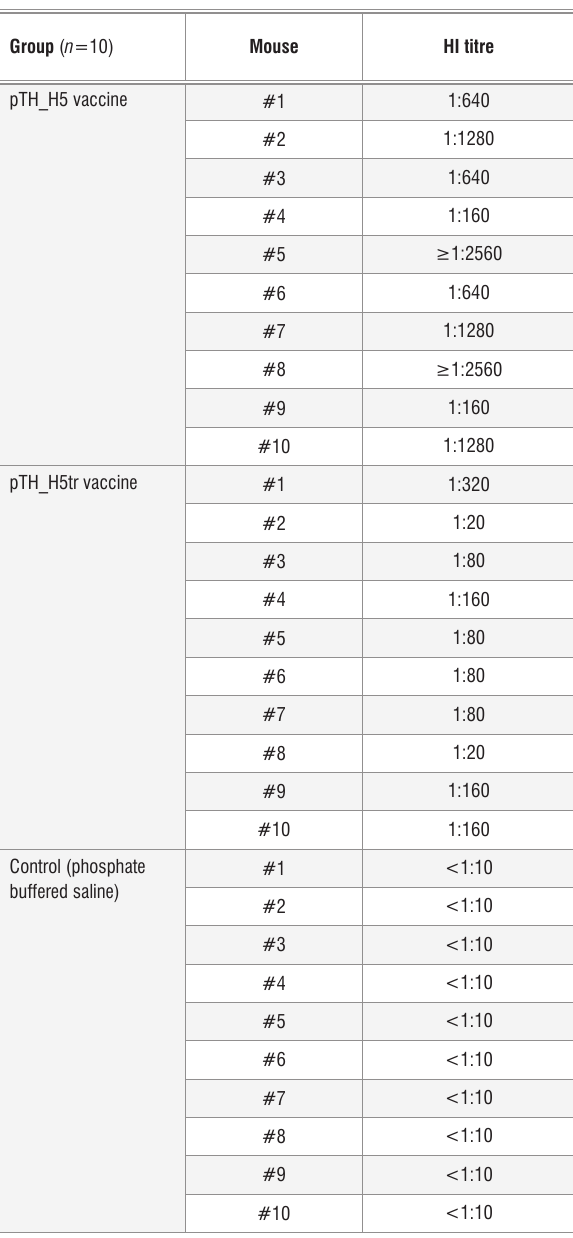
Table 1: Summary of the haemagglutination inhibition (HI) results obtained from the final sera samples of each individual female Balb/c mouse taken 2 weeks after the fourth vaccination